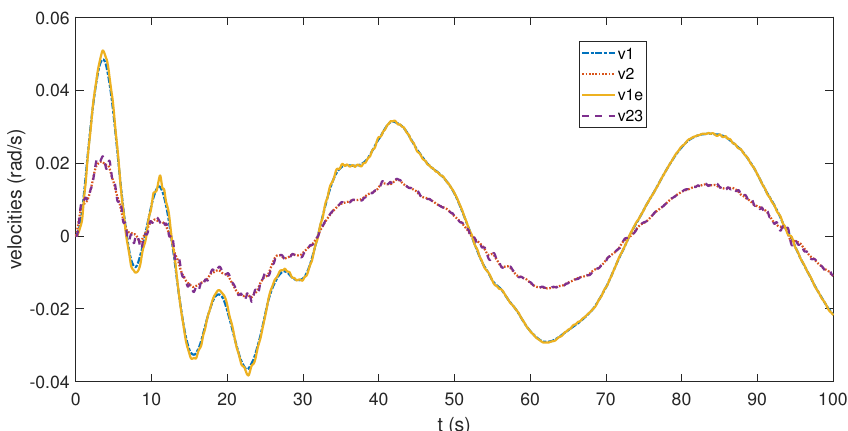
Figure 6. Velocity predictions under time-varying delay.